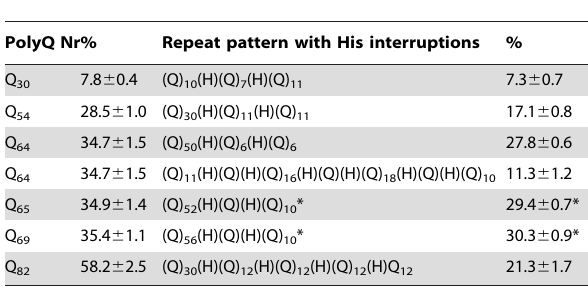
Table 1. Aggregation tendency indicated by cell counting analysis.